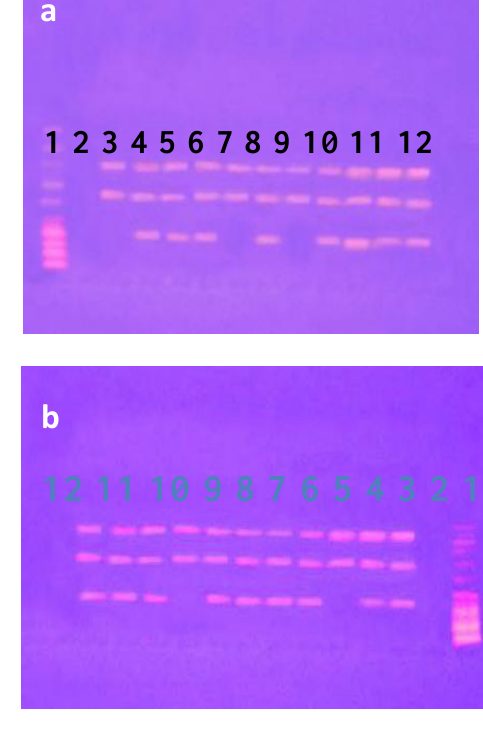
Figure, 1: Restriction patterns from Sac 1 digested P1-5EZ and P2-3EZ- PCR products of sheep embryos. Lane1: 100 bp ladder (marker). a- Sexed embryos at 200×g: Female lanes 4, and 9 only. Male lanes 2, 3, 5, 6, 7, 8, 10, 11 and 12. b- Sexed embryos at300×g: Female lanes 2, 6 and 8 only. Male lanes 3, 4, 5, 7, 9, 10, 11 and 12.